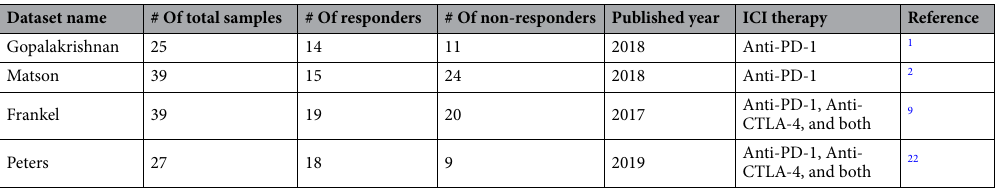
Table 1. Summary of gut microbiome datasets derived from shotgun metagenomic